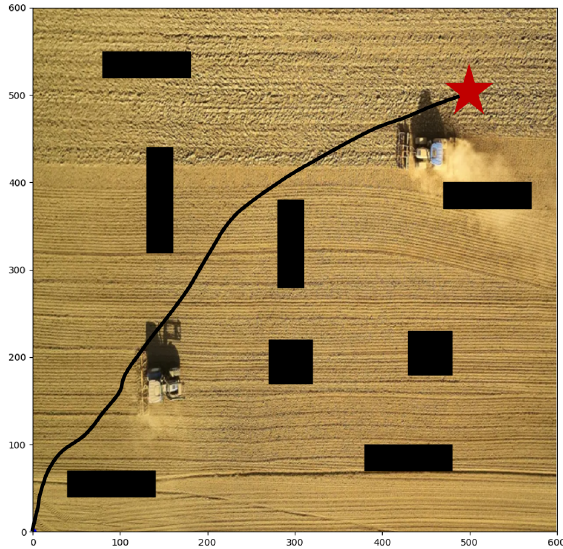
Figure 10. The planned path with target point of (500, 500) and dynamic obstacles.